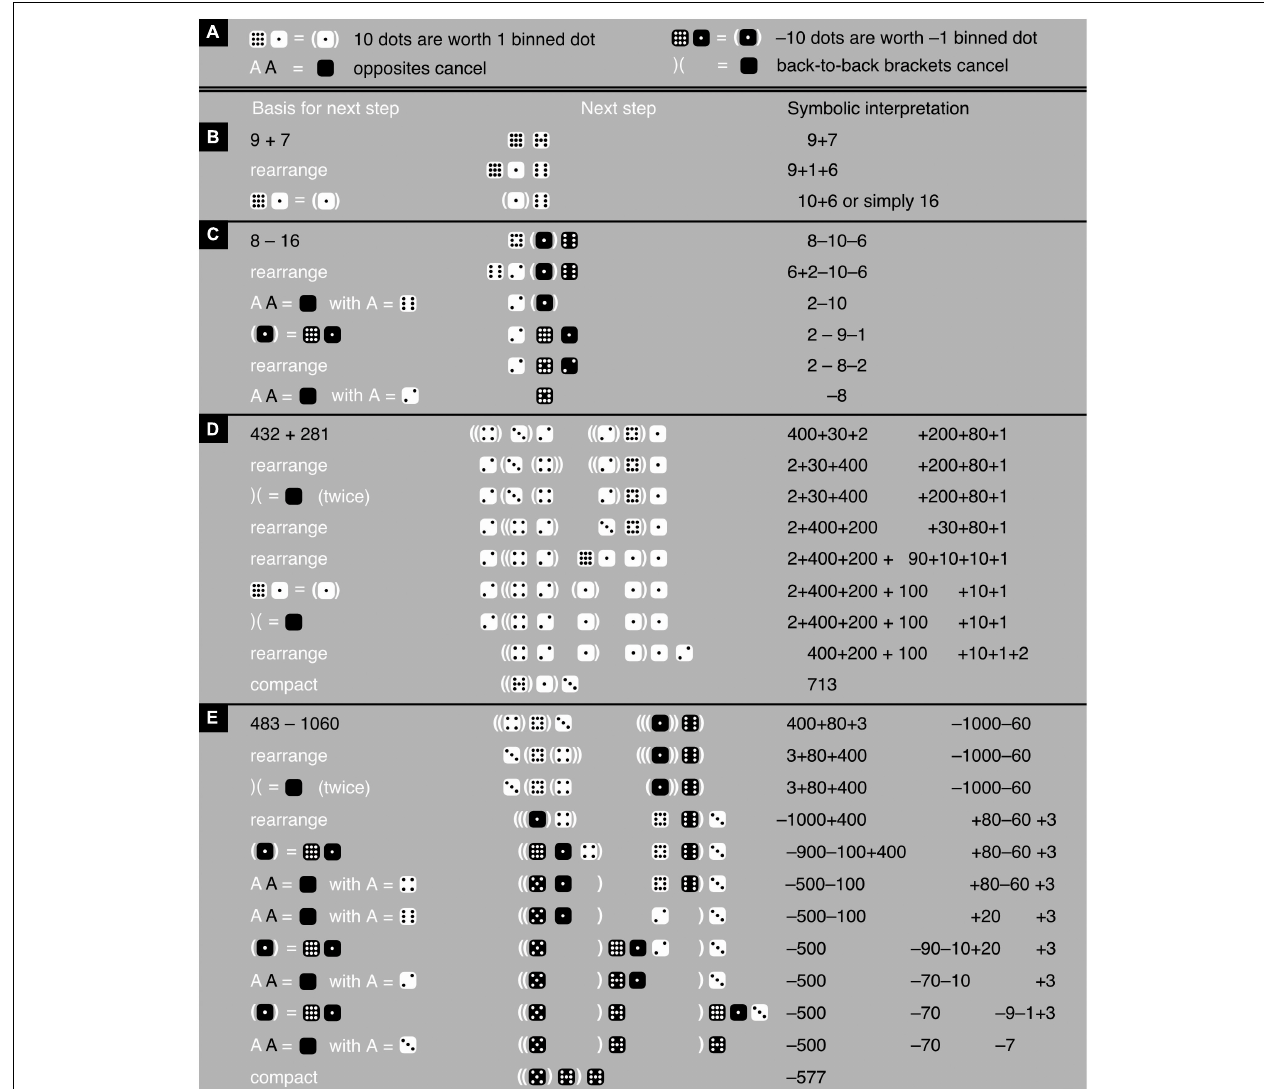
FIGURE 5 | Iconic addition and subtraction. (A) Provides the rules, whereby the first rule on the right can be derived from the first two rules on the left. (B–E) Shows examples of iconic addition and subtraction with—based on the provided rules—a justification for each next step in a calculation (left), the calculation-step itself (middle), and a symbolic interpretation (right). Note the following: First, the brackets that enclose a number need not be adjacent to this number. For instance, in the 432+281-example, the 4 of 432 is enclosed between two pairs of brackets even though the right-most bracket of one of these two pairs appears immediately to the right of the 3 and not the 4. The 3 itself is enclosed by one pair of brackets. Second, the order of iconic digits (mighty dice) within an iconic number is free and space between these digits optional, like in the final two examples. Third, in the end, just for readability, dots are binned, shifted to the right as much as standard notation allows, and compacted. Fourth, the iconic representation of a number and of an addition can coincide. For instance, in the 9+7-example, the iconic notations of 10+6 and of 16 are identical.